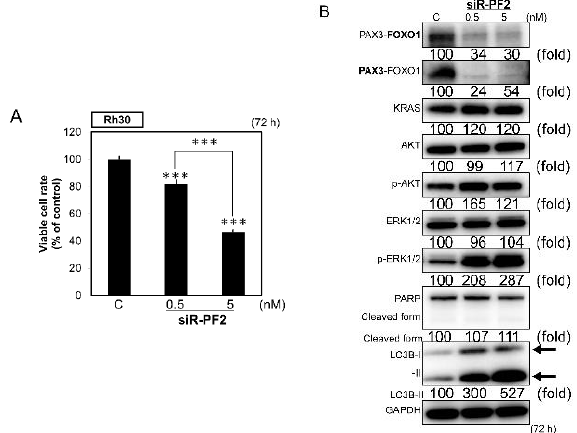
Figure 5. ( A , B ) Effects of PAX3–FOXO1 knockdown on cell growth ( A ) and protein expression levels of PAX3–FOXO1, KRAS, AKT, ERK1/2, PARP, and LC3B in Rh30 cells, as examined by Western blot of PAX3–FOXO1, KRAS, AKT, ERK1 / 2, PARP, and LC3B in Rh30 cells, as examined by Western blot analysis ( B ) 72 h after transfection of the cells with siR-PF2 at a concentration of 0.5 or 5 nM. siR-PF2 was synthesized by targeting the fusion sites between exon 7 of PAX3 and exon 2 of FOXO1. The knockdown of PAX3–FOXO1 was performed using siR-PF2 [40]. PAX3–FOXO1 was detected using the antibody indicated in bold. Results are presented as mean ± SD; *** p <